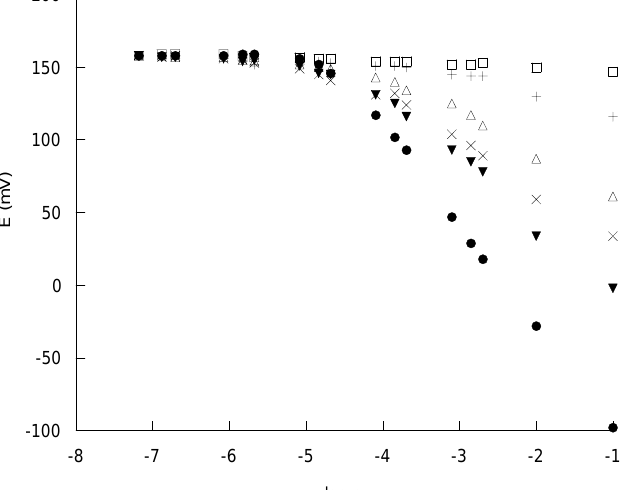
Figure 2. Potentiometric anion response to perchlorate ( • ) of the electrode L 1 containing DBP as plasticizer at pH 7 in the presence of certain anions, ( ▼ ) thiocyanate, ( Χ ) bromide, ( ∆ ) nitrate, (+) chloride, ( □ )